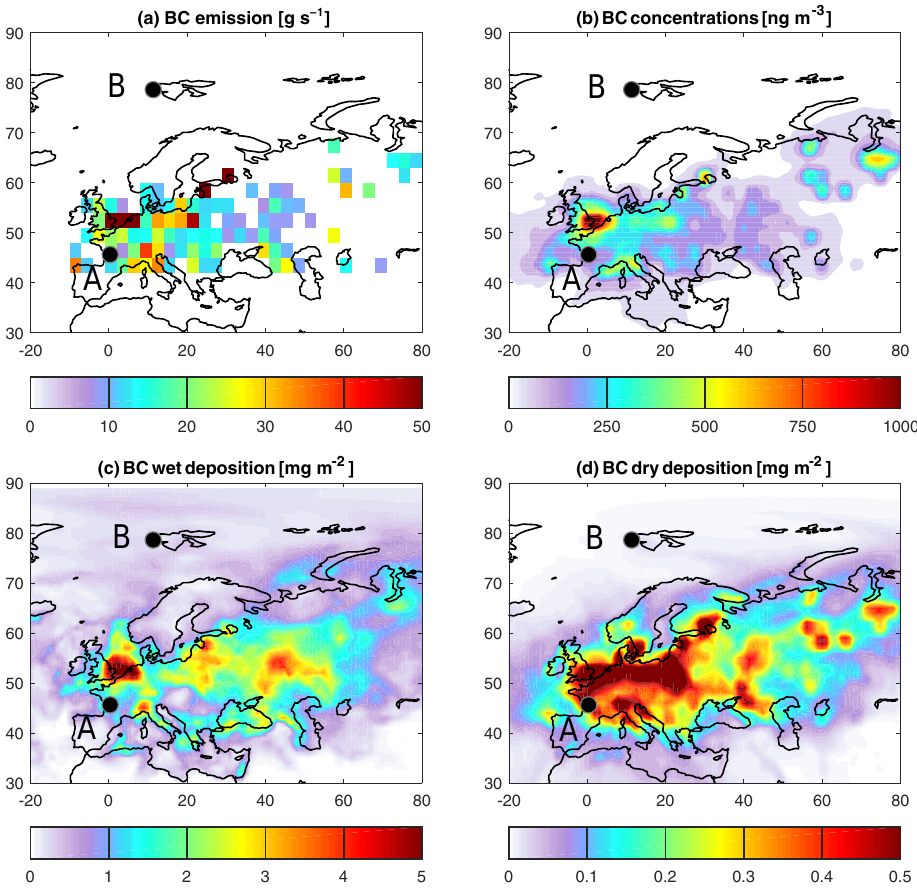
Figure 4. Average BC emission fluxes (a) , average BC concentrations in the lowest model layer (0–100m) (b) , accumulated BC wet depo- sition (c) and accumulated BC dry deposition (d) for the period of 1 March to 1 April 2012. The black dots show the locations A and B for which a detailed comparison of forward and backward calculations is